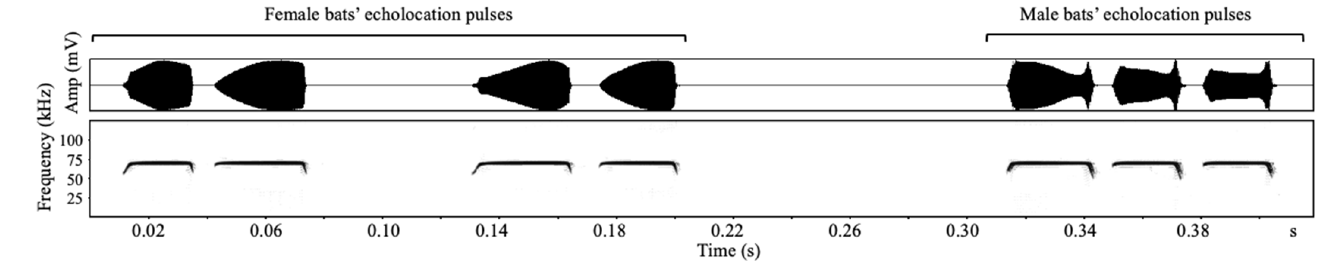
Figure 1. Spectrograms of a set of echolocation pulses for female ( left ) and male ( right ) Rhinolophus ferrumequinum.